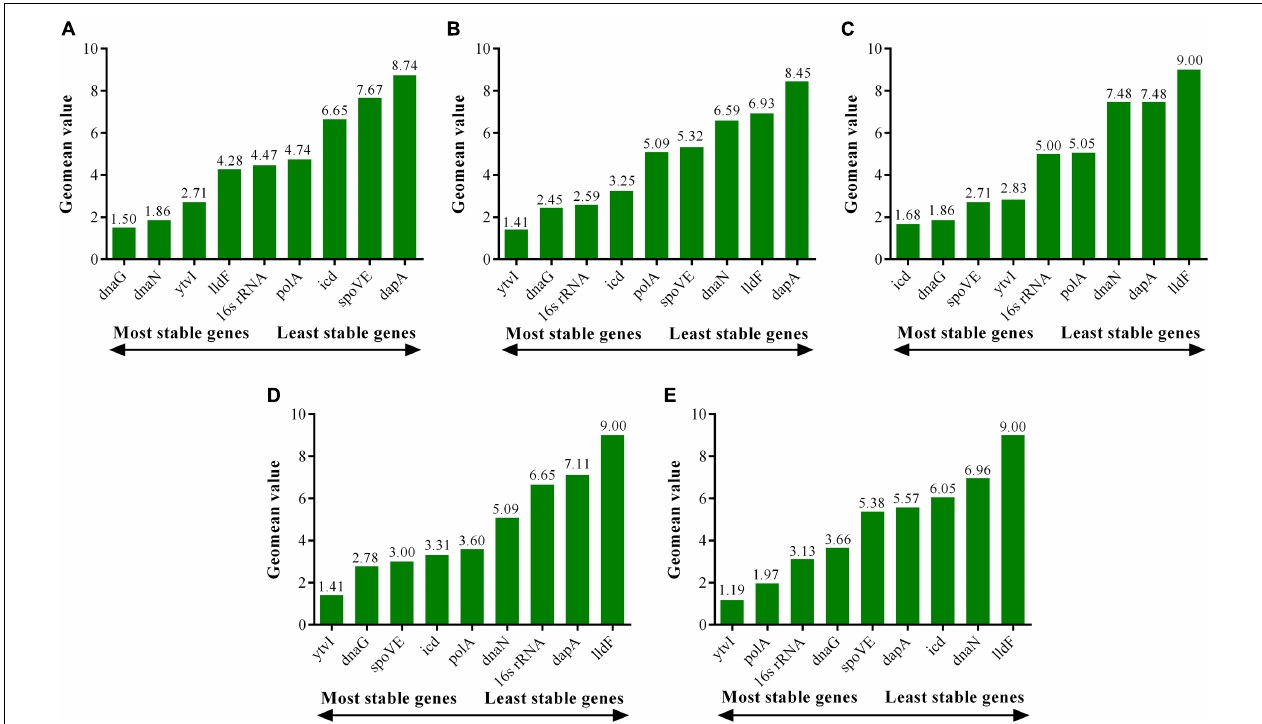
FIGURE 7 | Expression stability of candidate reference genes in A. acidoterrestris assessed by RefFinder program. (A–D) A. acidoterrestris cells treated at pH 4.0, 3.5, 3.0, and 2.5, respectively. (E) All samples.